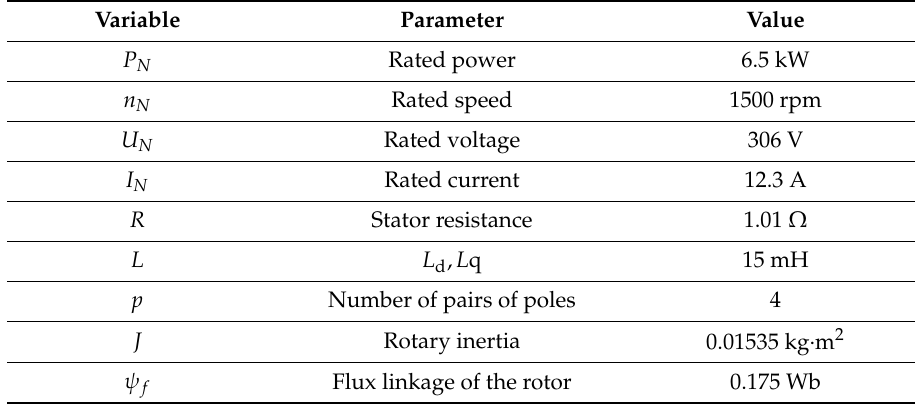
Table 3. Surface-mounted permanent magnet synchronous motor (SPMSM) parameters for simulation.